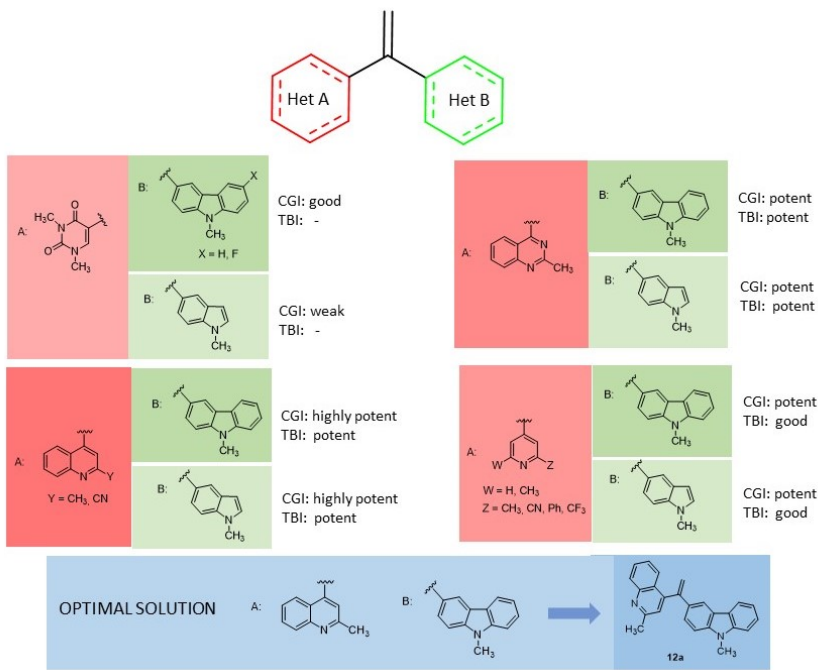
Figure 4. SAR [66] summary for HCT 116 cell growth inhibition (CGI) and tubulin polymerization inhibition (TBI) of indole based derivatives 12 .